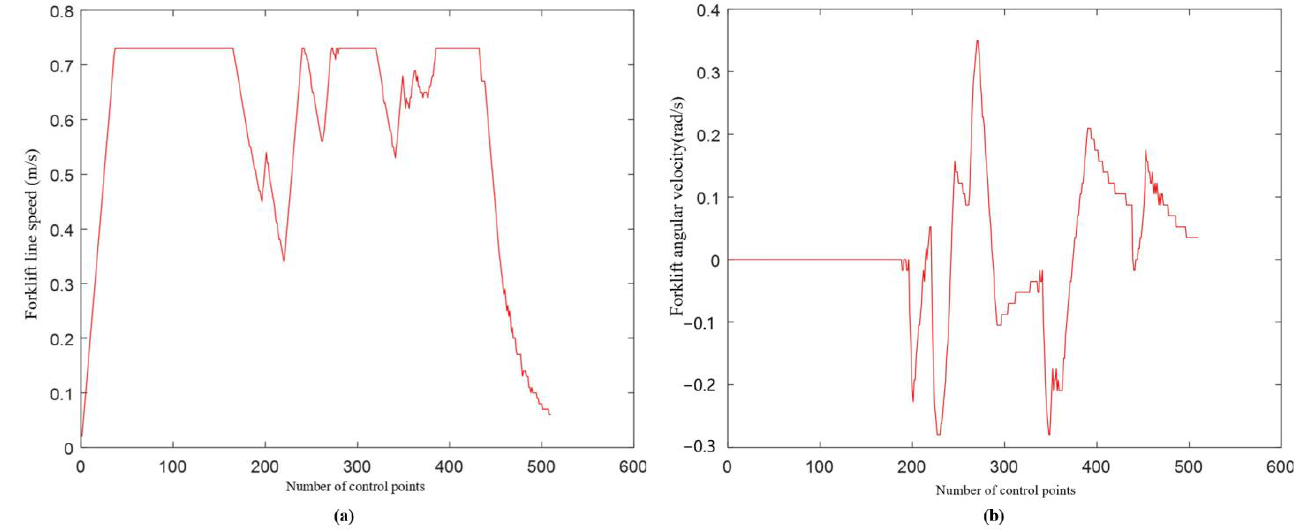
Figure 11. Simulation results of improved evaluation function: ( a ) linear speed of FAGV, ( b ) angular velocity of FAGV.